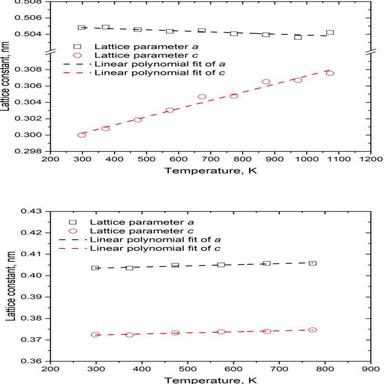
Lattice parameters of (a) hexagonal-UFe3B2 from 298 to 1073 K (b) hexagonal-USiNi from 298 to 773 K.